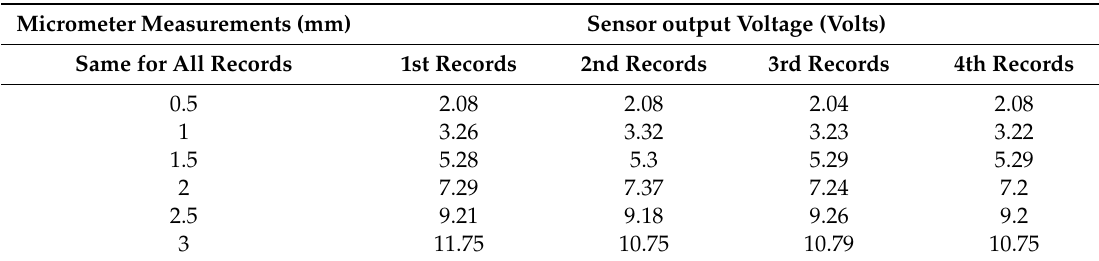
Table 2. Repeated measurements of disk displacement by inductive sensor and a micrometer taken at a same occasion. Input voltage to the sensor is 15